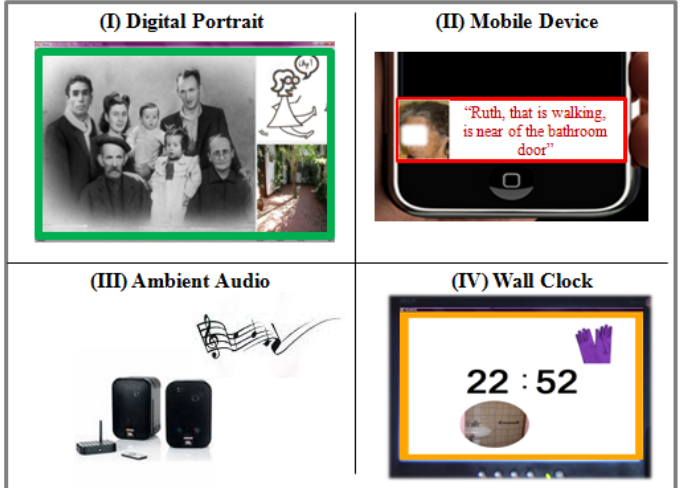
Figure 11. Implemented CANoE-Aw Notification